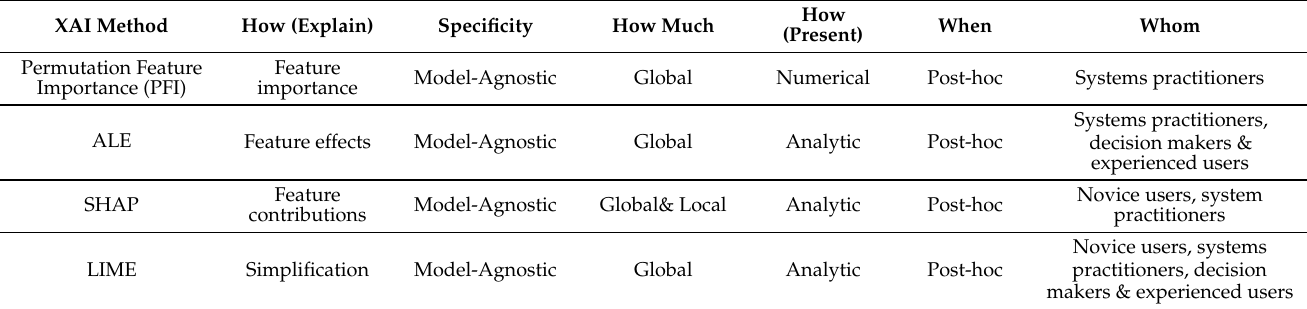
Table 2. Explainability dimensions applied on inspected XAI